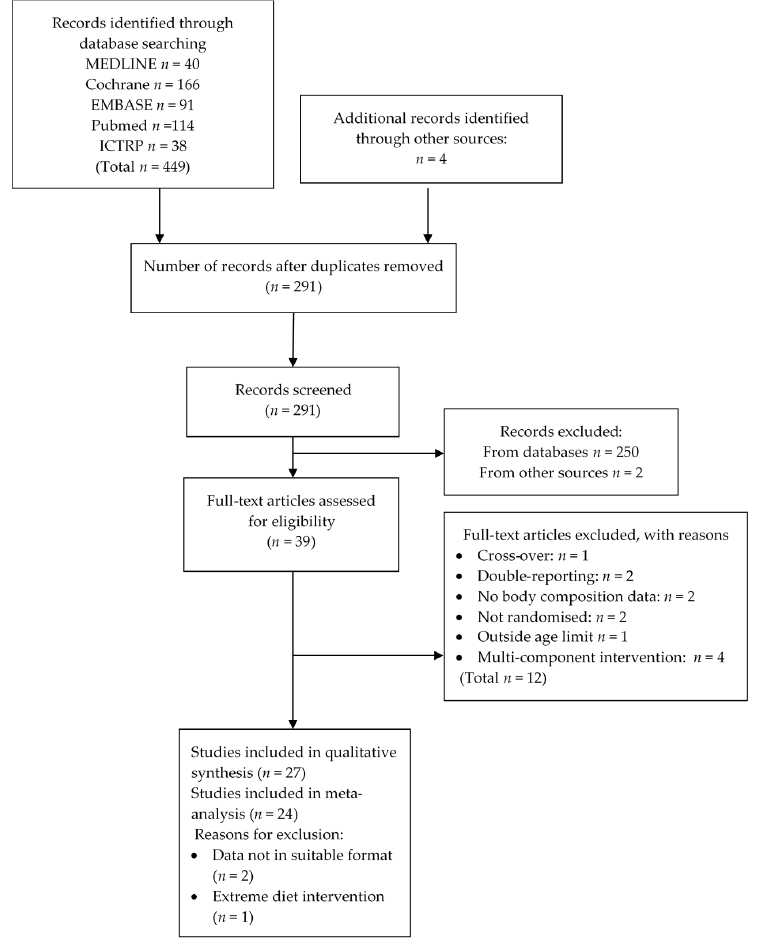
Figure 1. Flow diagram for selection of studies (ICTRP, International Clinical Trials Registry Platform).